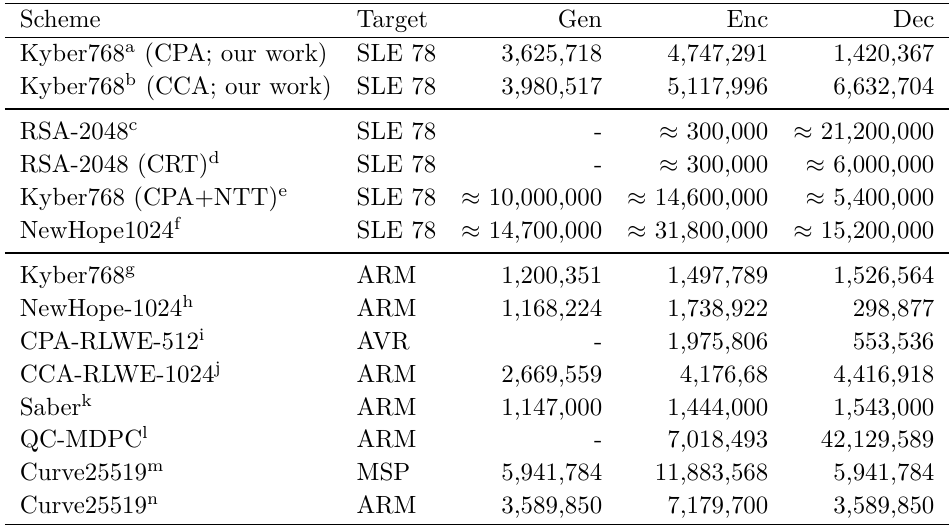
Table 4: Comparison of our work with other PKE or KEM schemes on various microcon- troller platforms in clock